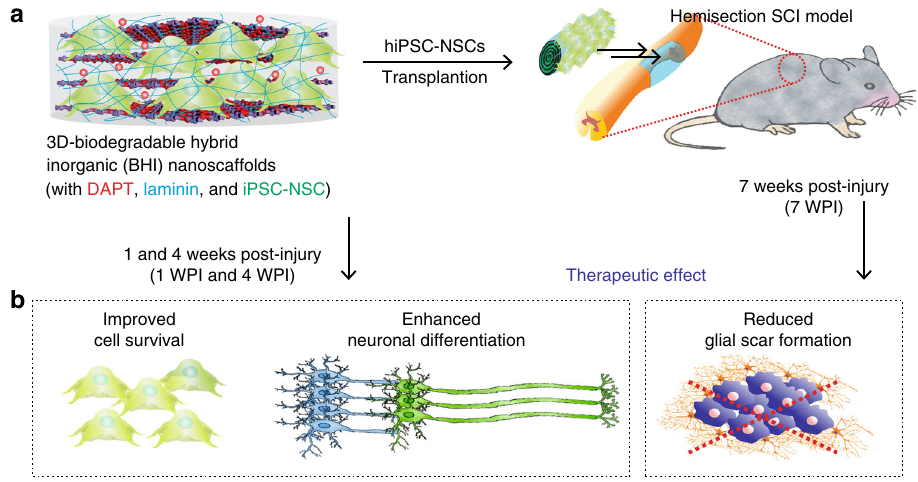
Fig. 6 Pathways of enhanced stem cell transplantation into SCI sites by 3D-BHI nanoscaffolds. a , b , Schematic diagram ( a ) showing the enhanced transplantation of iPSC-NSC in a murine lateral hemisection SCI model by 3D BHI nanoscaffold and the proposed mechanisms ( b ) for the enhanced transplantation and potential bene fi cial effects on overcoming inhibitory microenvironments in the SCI